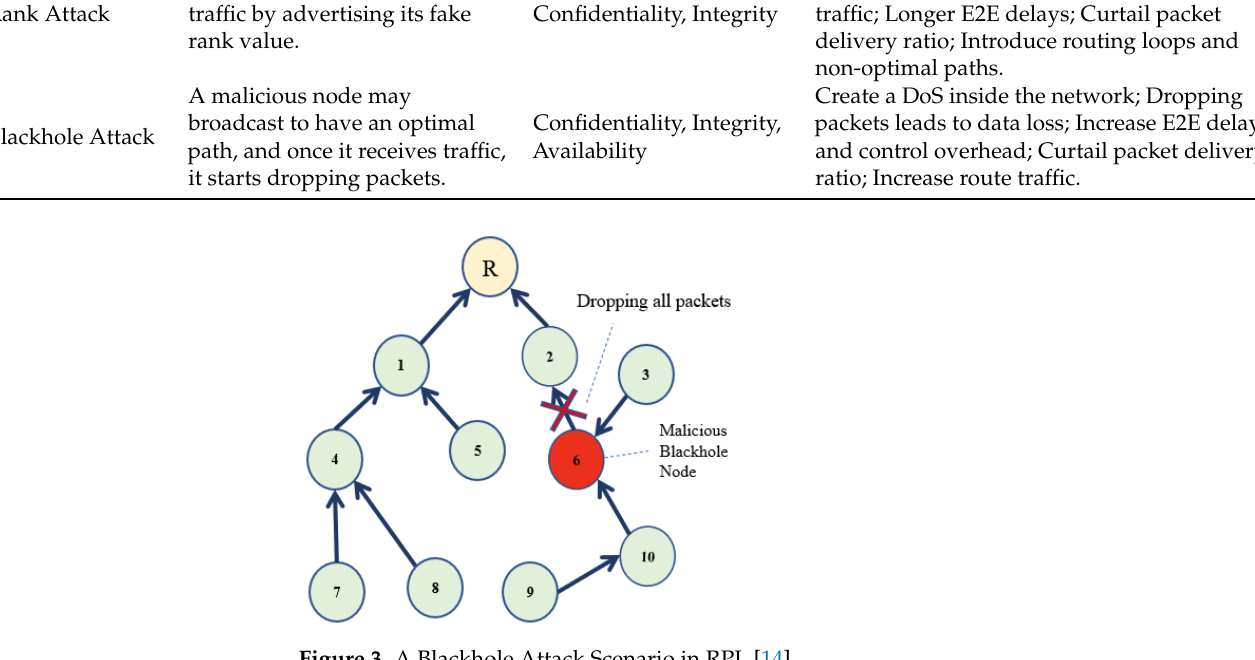
Figure 3. A Blackhole Attack Scenario in RPL [14]. Table 1. Description of Attacks Under Consideration for Proposed Secure Routing